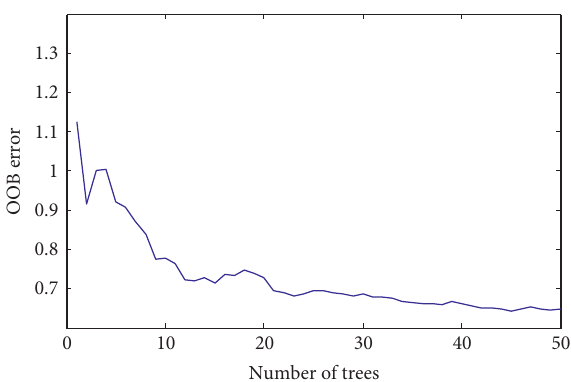
Figure 7: Out-of-bag error of the random forest